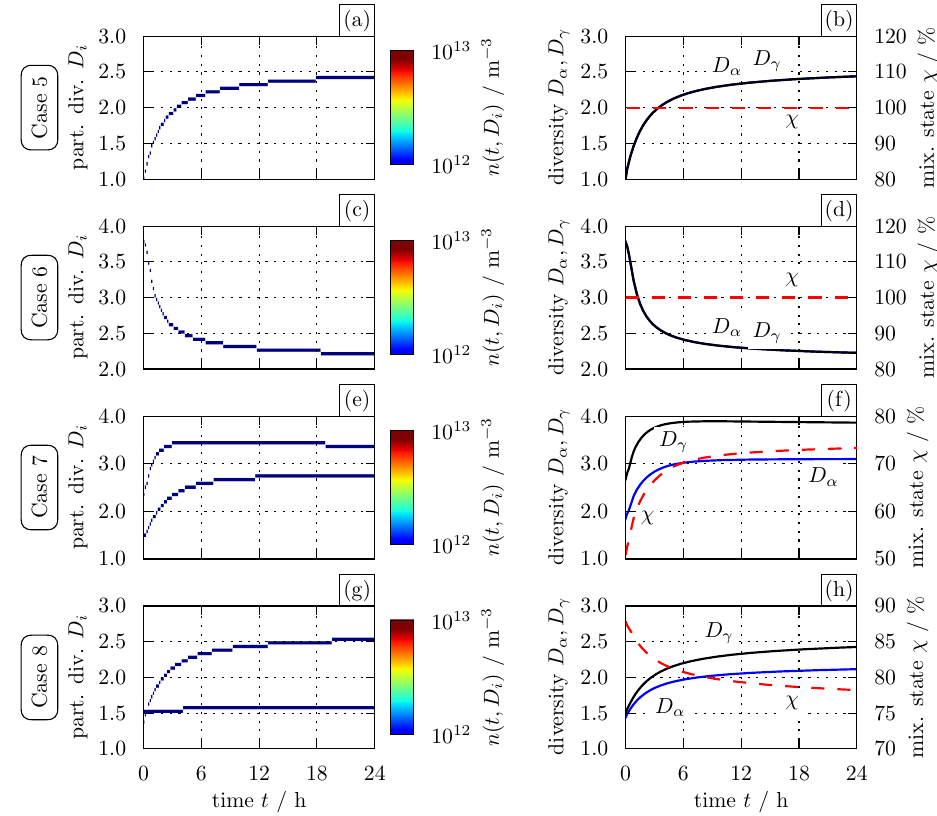
Fig. 4. Diversity and mixing state evolution for archetypal cases. Left column: distributions of per-particle diversity D i as a function of time. Right column: time series of average particle diversity D α , population diversity D γ , and the mixing state index χ . Note that the left axis shows D α and D γ , and the right axis shows χ . The rows correspond to Cases 5 to 8 as defined in Table